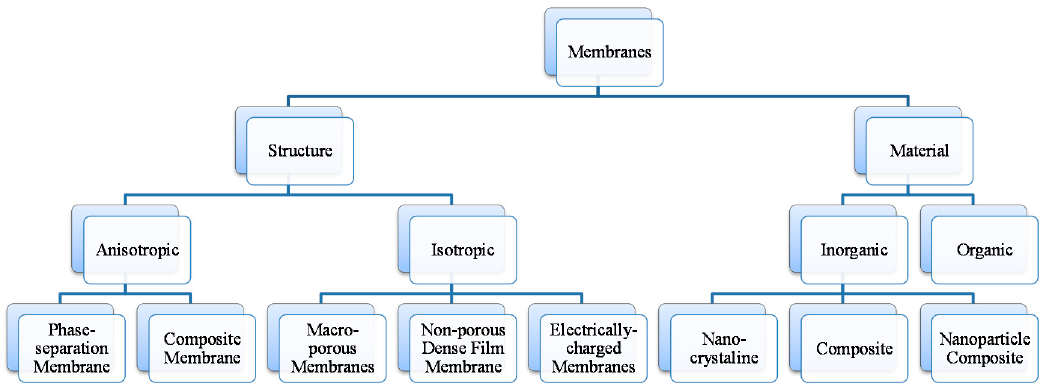
Figure 2. Membrane categories based on their structure and material.